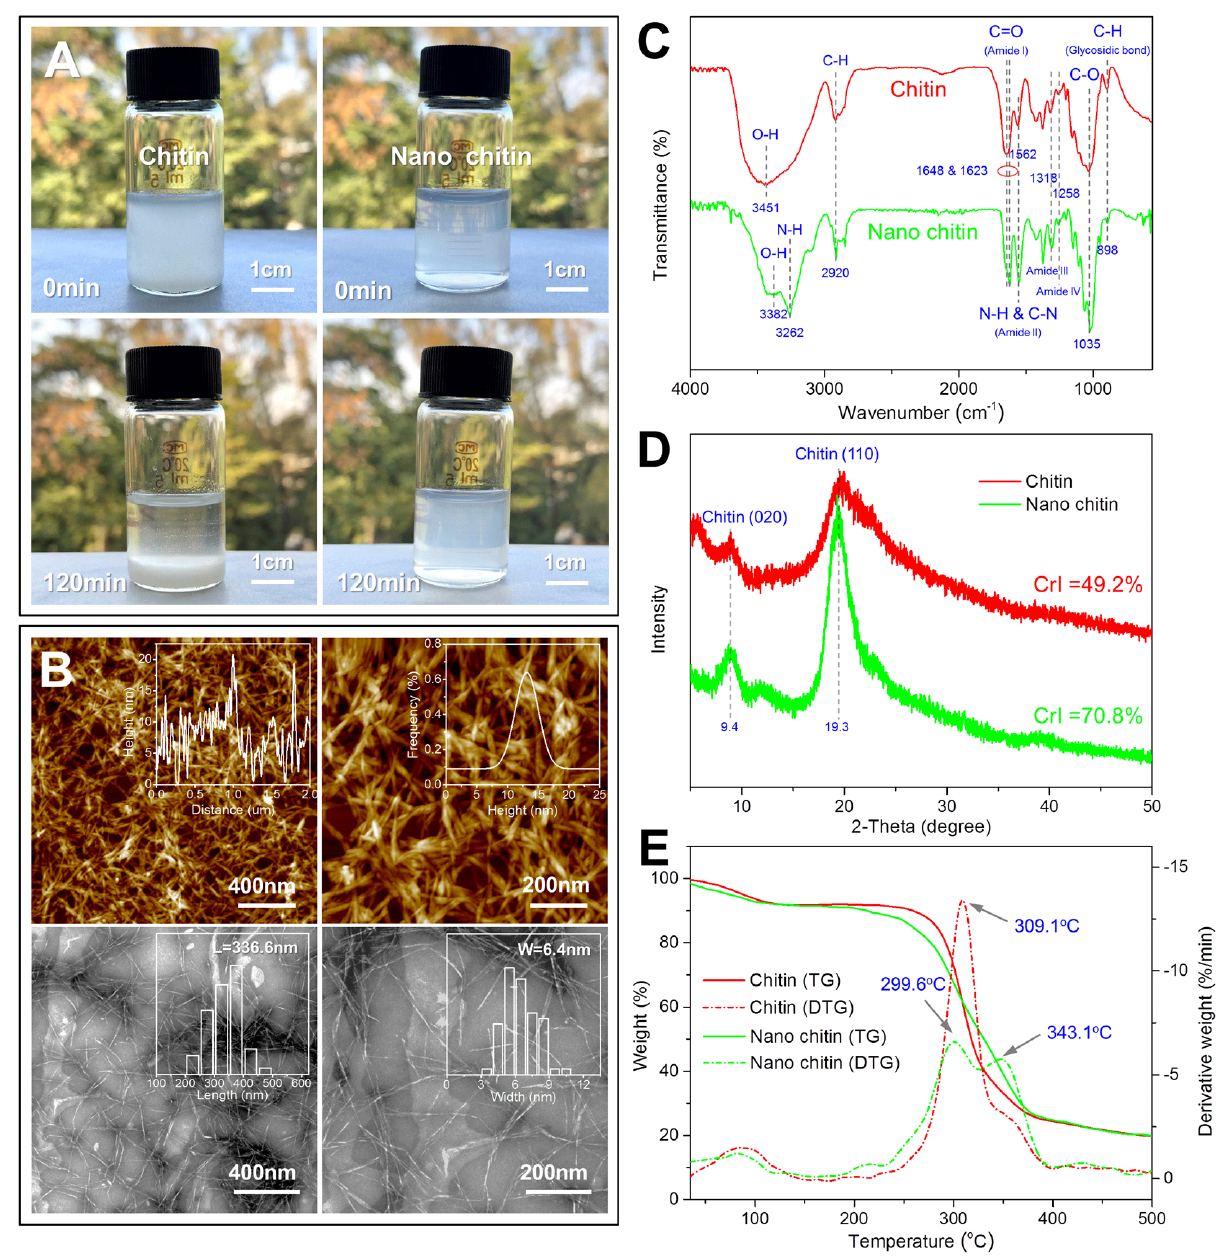
Figure 1. Optical photographs of chitin and nano chitin dispersed in water for 0 min and 120 min ( A ). AFM and TEM images of nano chitin ( B ). FTIR spectra ( C ), X − ray diffraction patterns ( D ), and TG − DTG curves ( E ) of chitin and nano chitin.